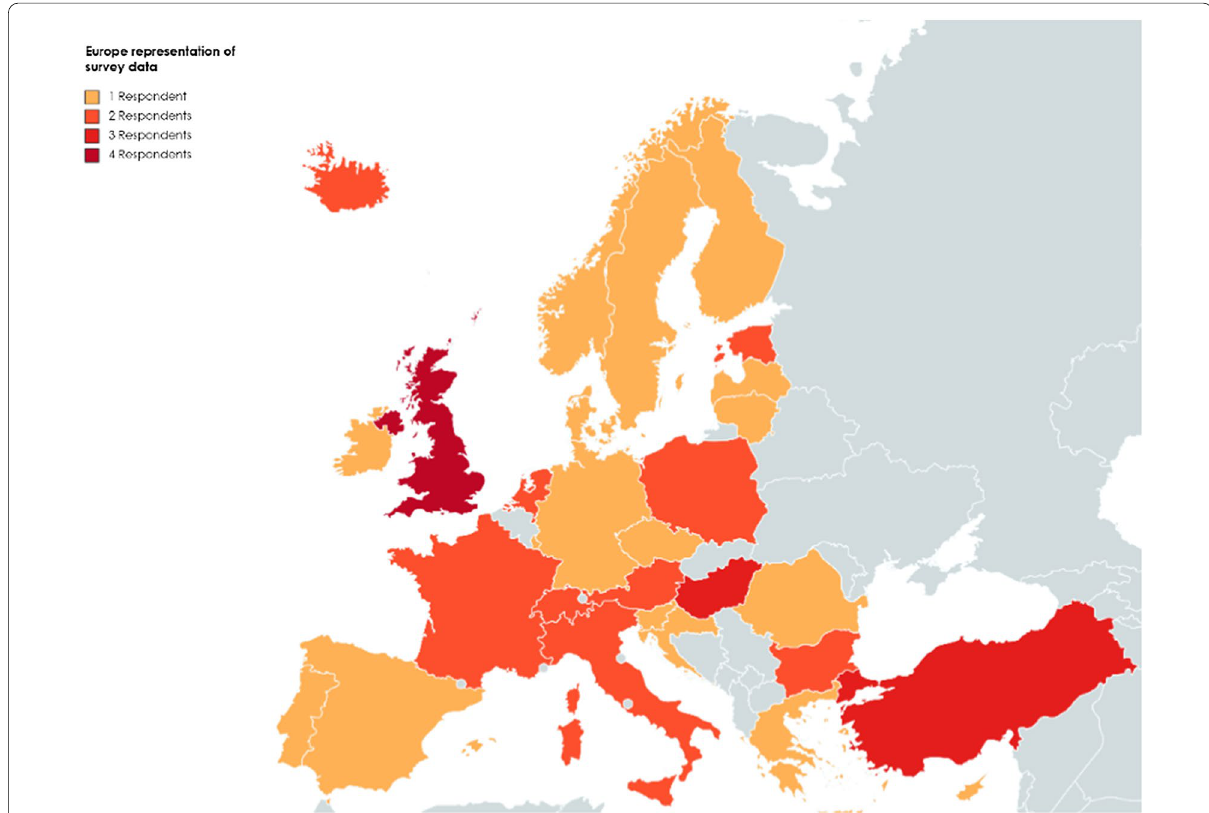
Fig. 1 Distribution of completed surveys by